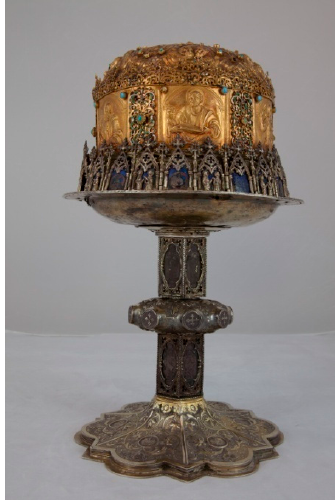
Figure 3. Reliquary of Saint Tryphon’s head (“Glorious Head”), 15th–17th century, gold, sliver, enamel, rock crystal, jewels, 43 cm × 27 cm × 23 cm, Kotor, Saint Tryphon’s relic chapel (photo by Stevan Kordi ć ).